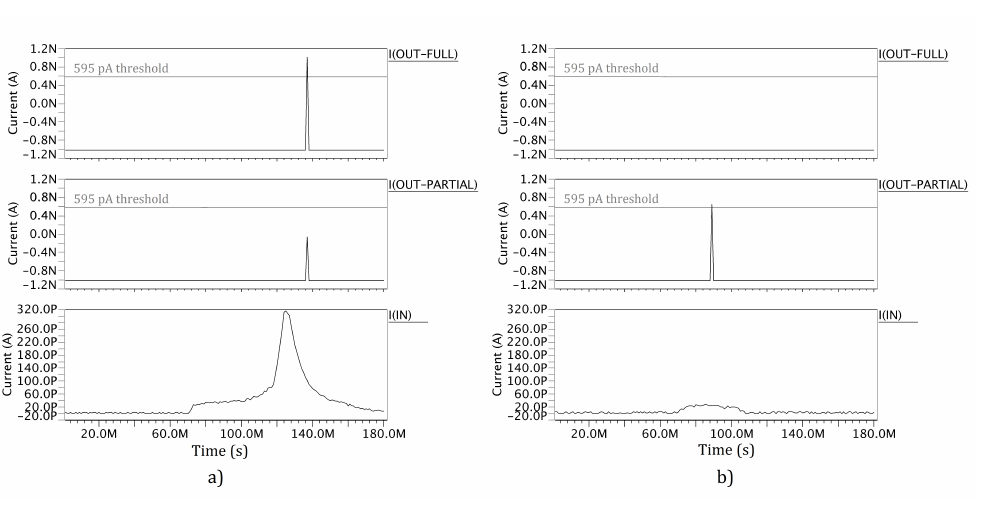
Figure 14. Examples of CMOS classifier responses: ( a ) for full fusion, ( b ) for partial fu-